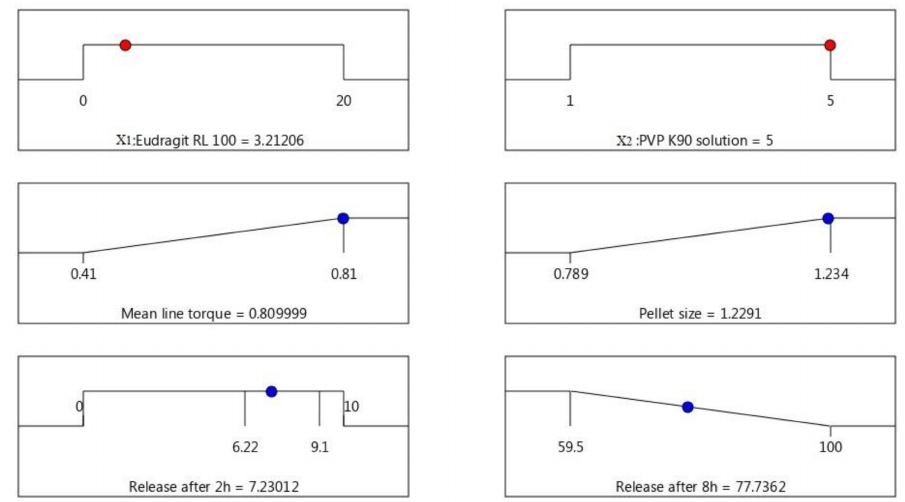
Figure 5. Statistical program checkpoint for the desirability of independent (X1 and X2) and dependent factors of AC sustained-release matrix pellet formulation.